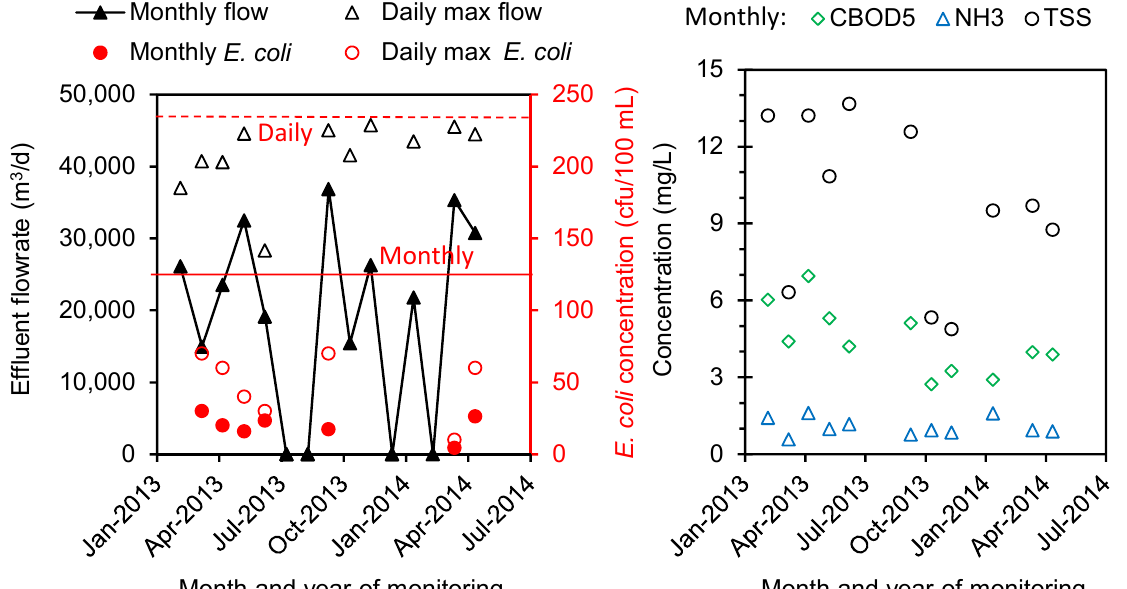
Figure 5. Effluent flow rate and quality of Washington CSO wetland treatment system. Data source: USEPA [8]. Horizontal red lines are permit limits for E . coli